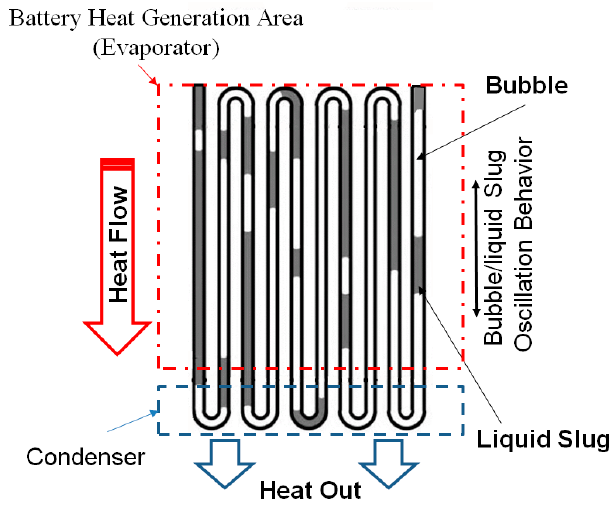
Figure 1. Oscillating heat pipe (OHP).